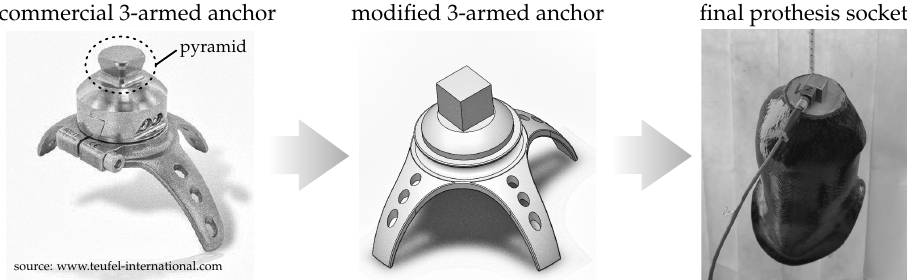
Figure 2. Modification of the 3-armed anchor and integration into final prosthesis